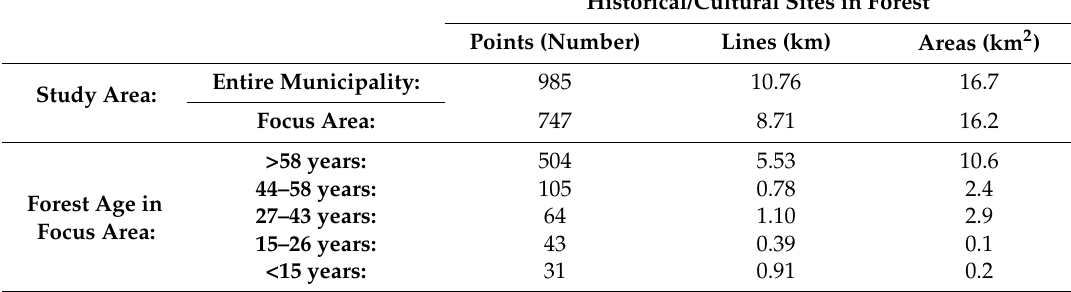
Table 2. Historically and culturally valuable objects and sites in forests of different ages in the entire Vilhelmina municipality (Sweden) and in our focus study area. The objects and sites are recorded as points, lines, and areas.